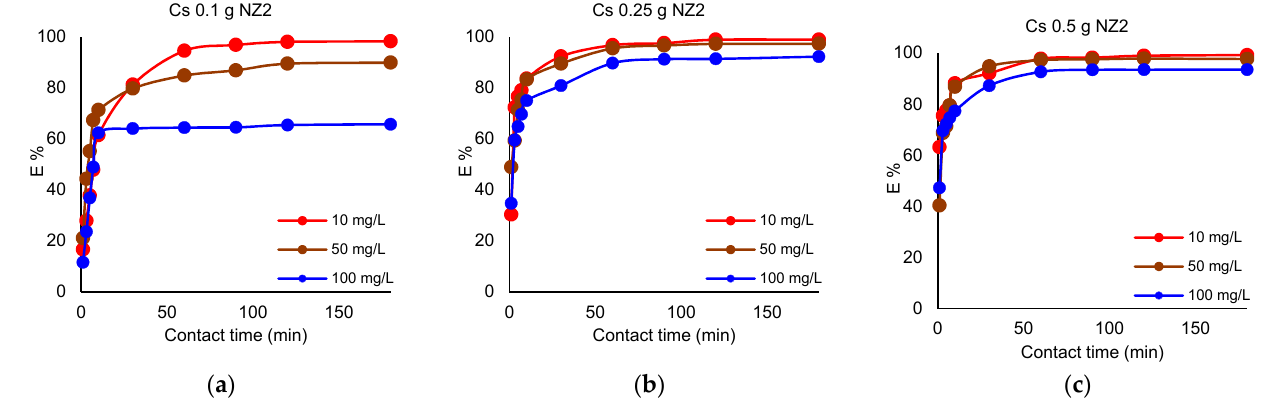
Figure 3. Removal efficiency (%) of Cs + by different NZ2 quantities; ( a ) 0.1 g, ( b ) 0.25 g, ( c ) 0.5 g; V = 50 mL; 200 rpm; 22 ± 2 ◦ C, 180